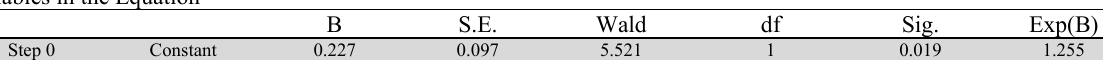
Variables in the Equation